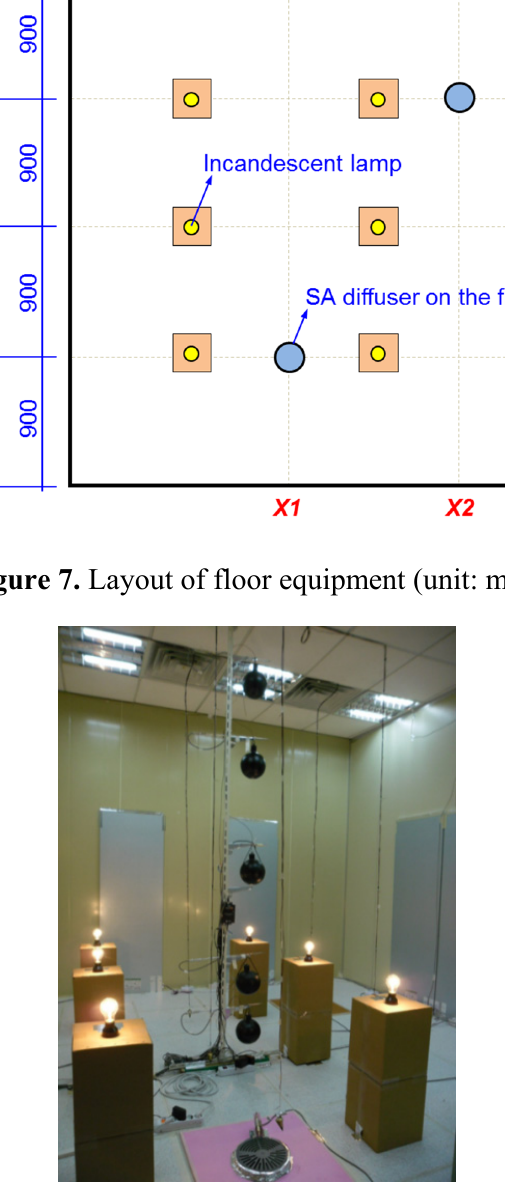
Figure 8. Interior of experimental